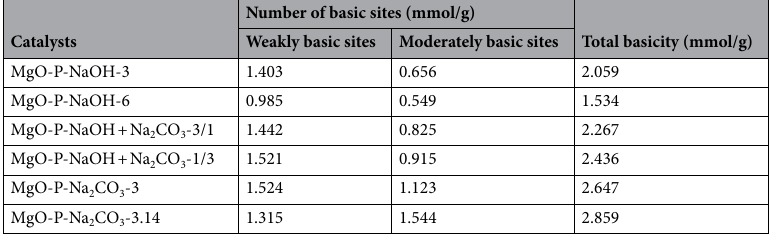
Table 3. The basicity distribution of different MgO catalysts.